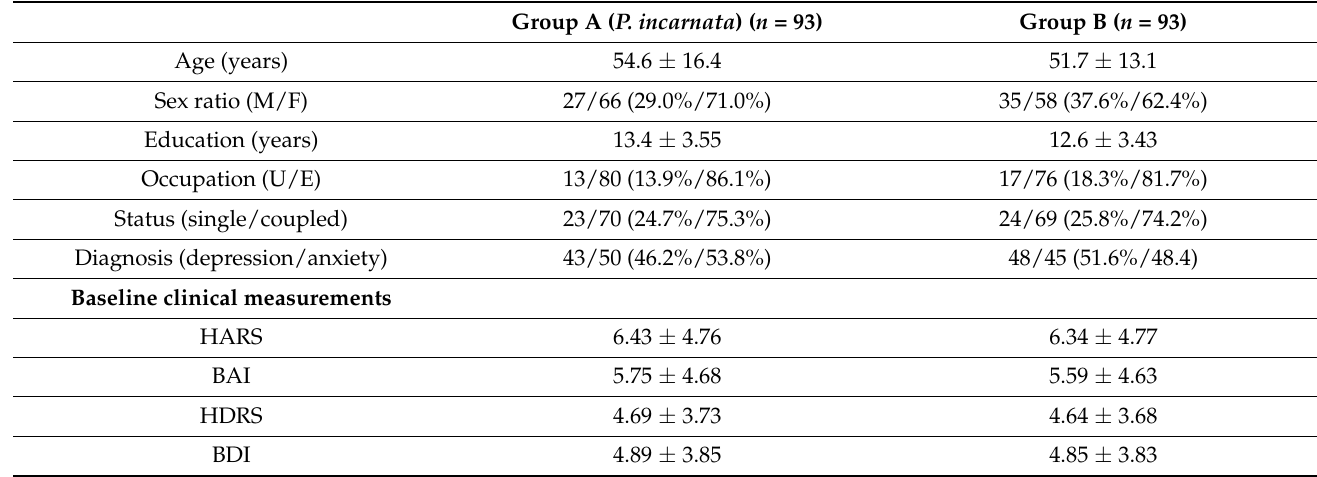
Table 1. Sociodemographics and clinical data of the sample.